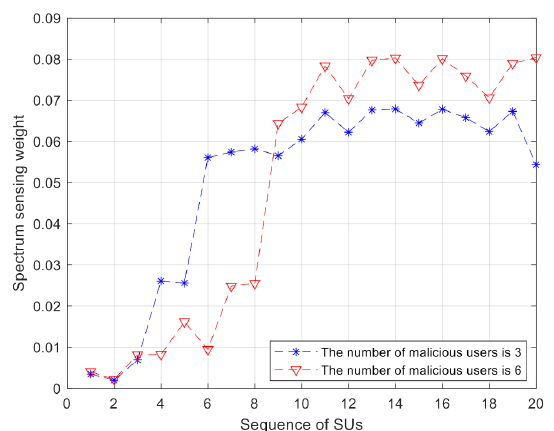
Figure 10. Weight distributions of nodes with different number of malicious